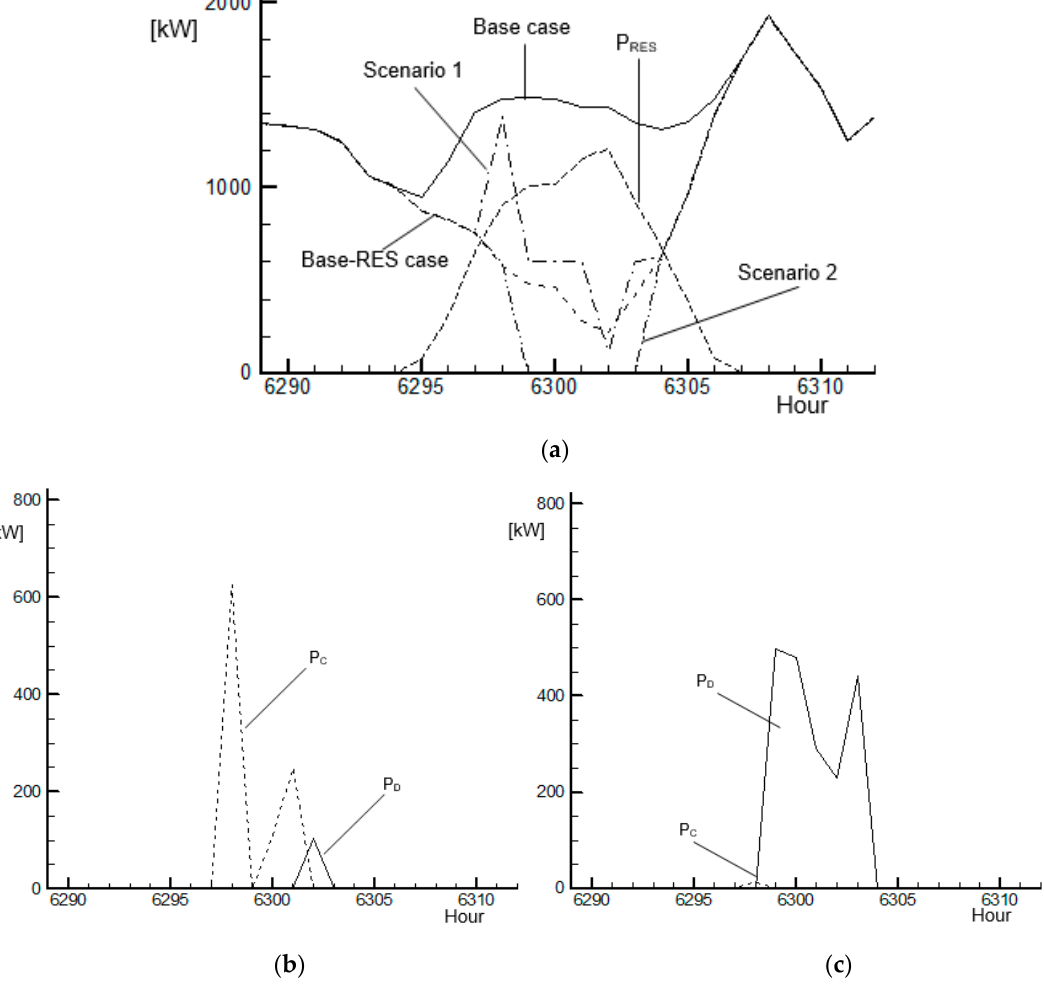
Figure 13. Representative day behavior of ( a ) RES availability and generator set supplied power; ( b ) charge/discharge power for scenario 1 ; ( c ) charge/discharge power for scenario 2 .